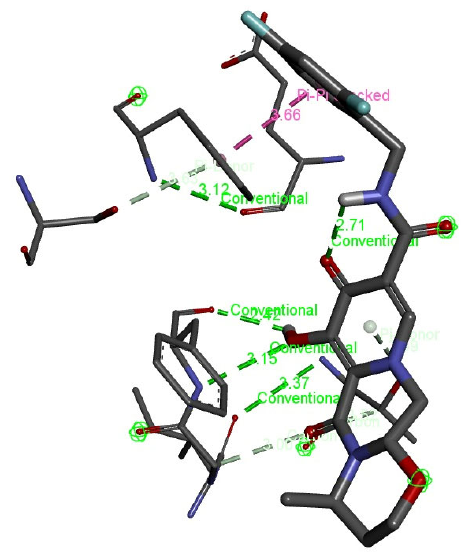
Figure 6. Visualization of hydrogen bonds and van der Waals interactions (dotted green lines) with bond lengths between chain-engineered active compound dolutegravir and MPXVgp169 virulent protein by Discovery Studio.